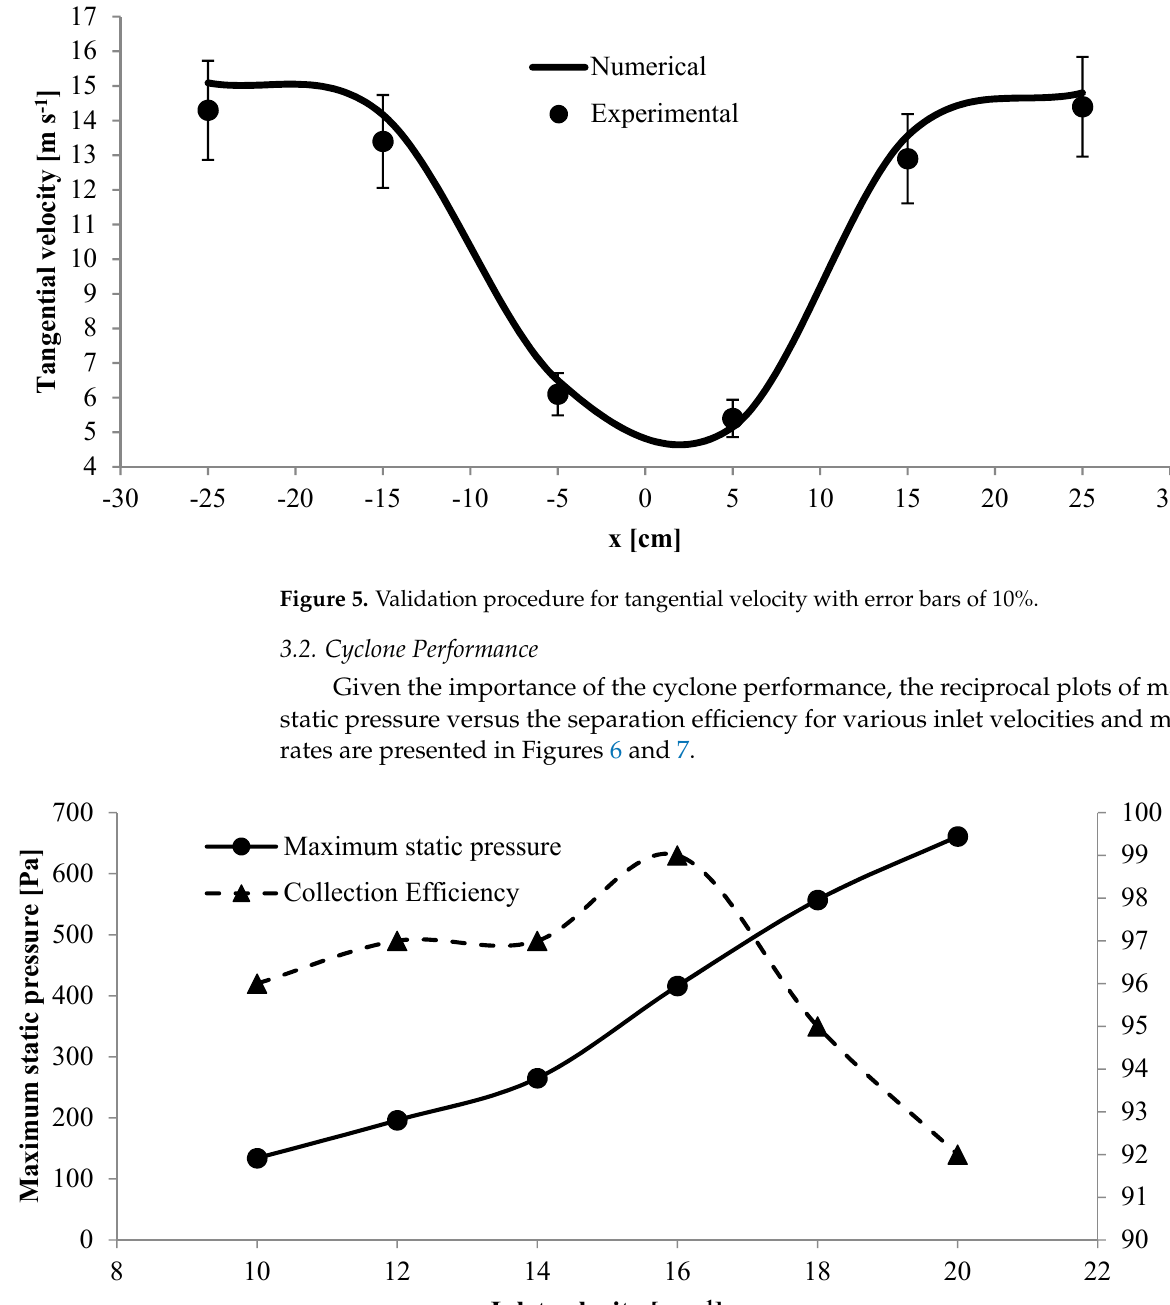
Figure 4. Validation procedure for pressure drop with error bars of 10%.